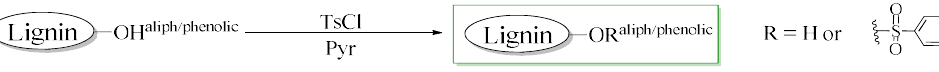
Figure 1. Reaction scheme for synthesizing tosylated lignin. Abbreviations: –OH aliph —aliphatic hydroxyl groups in lignin (1.65 mmol g −1 as determined by 31 P-NMR measurement); –OH phenolic —phenolic hydroxyl groups in lignin (2.12 mmol g −1 as determined by 31 P-NMR measurement); TsCl—tosyl chloride; and Pyr—pyridine.